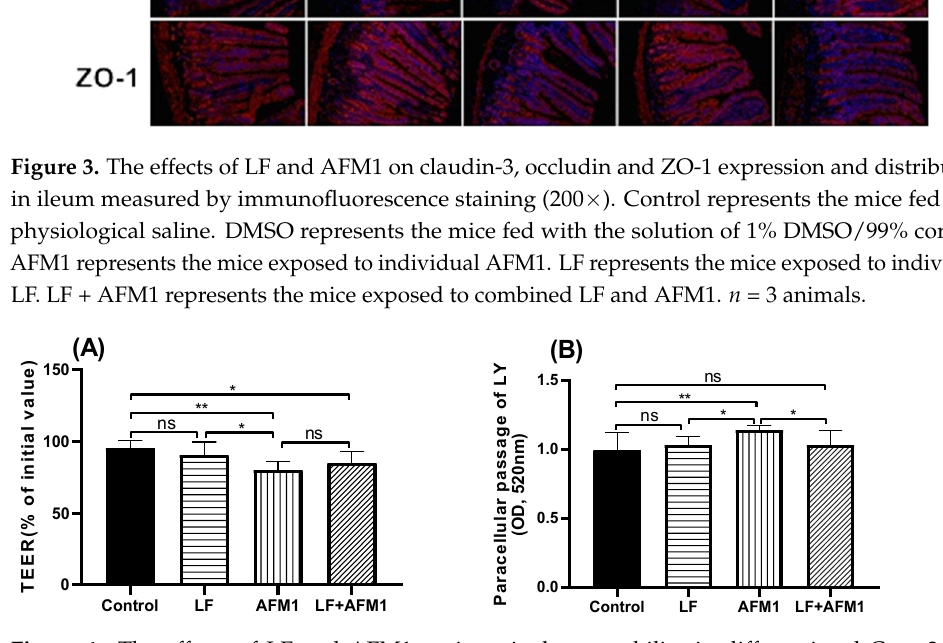
Figure 3. The effects of LF and AFM1 on claudin-3, occludin and ZO-1 expression and distribution in ileum measured by immunofluorescence staining (200×). Control represents the mice fed with physiological saline. DMSO represents the mice fed with the solution of 1% DMSO/99% corn oil. AFM1 represents the mice exposed to individual AFM1. LF represents the mice exposed to individ- ual LF. LF + AFM1 represents the mice exposed to combined LF and AFM1. n = 3 animals.